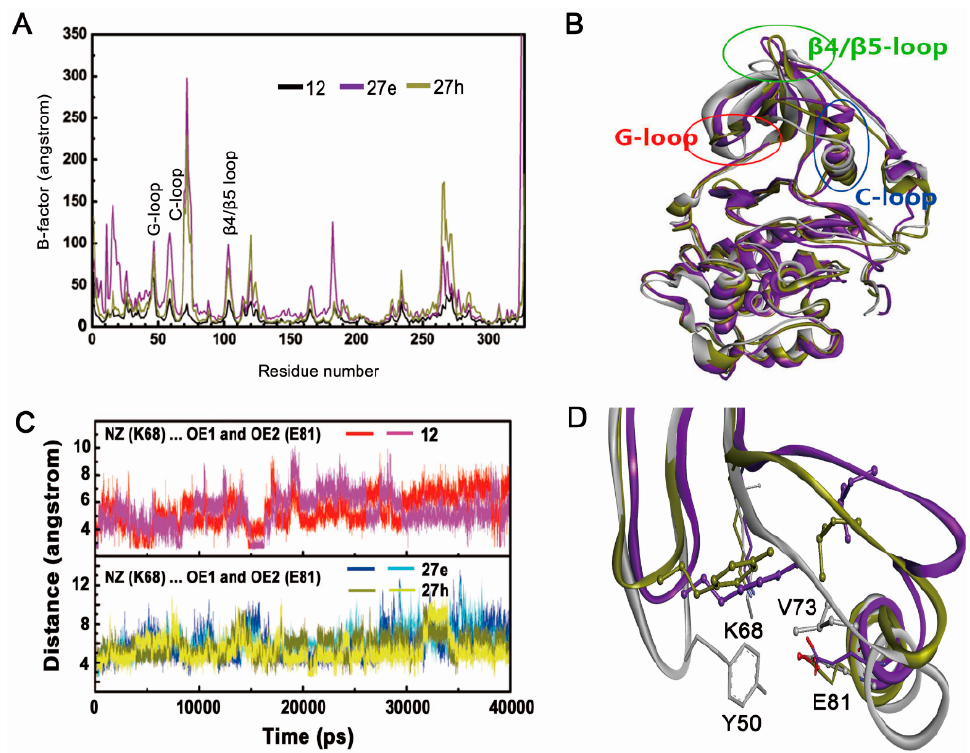
Figure 3. ( A ) Calculated per-residue B-factor of three complexes systems; ( B ) Superimposed average structures of CK2 α – 12 (gray), CK2 α – 27e (purple) and CK2 α – 27h (brown) complexes; ( C ) Time evolution of distances between NZ atoms of Lys68 and OE1 and OE2 atoms of Glu81; ( D ) Coupled interactions between C-loop and G-loop in CK2 α – 12 (gray), CK2 α – 27e (purple) and CK2 α – 27h (brown).